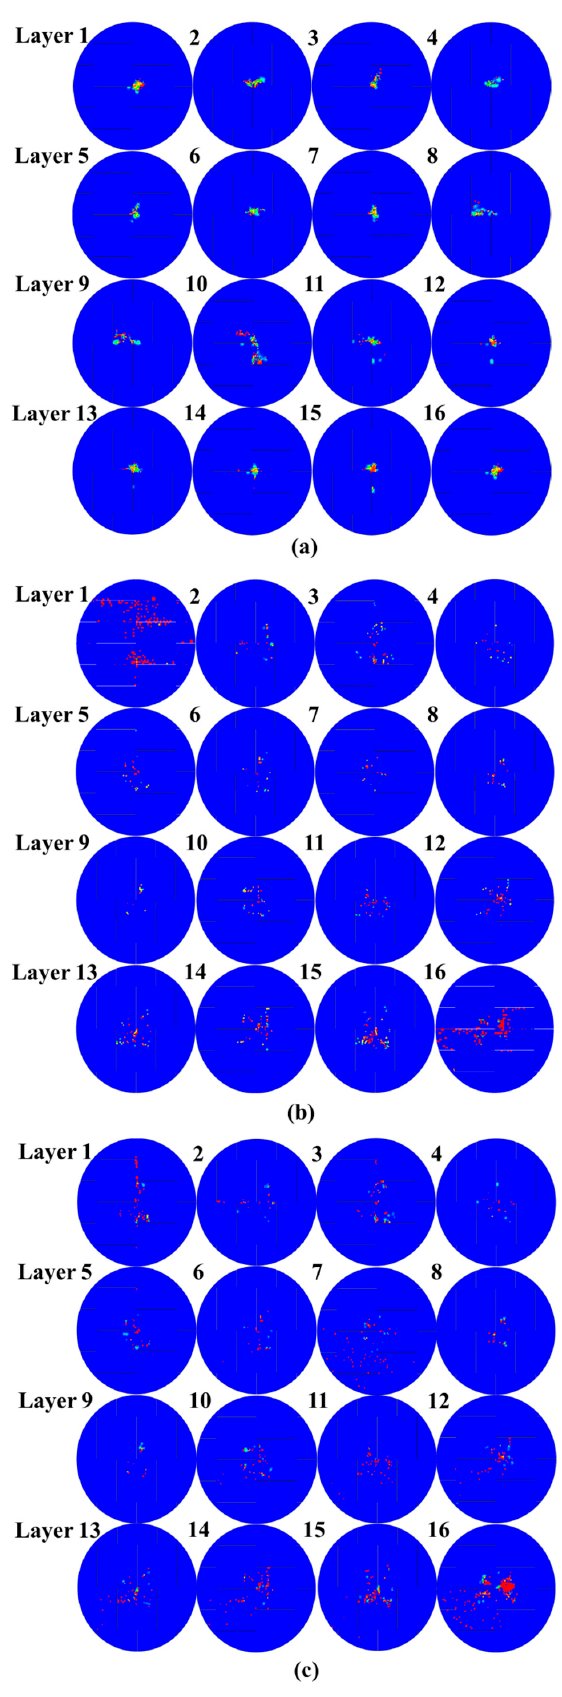
Figure 10. Fiber tensile damage of UACS laminates under impacts at ( a ) 4 J, ( b ) 7 J and ( c ) 11